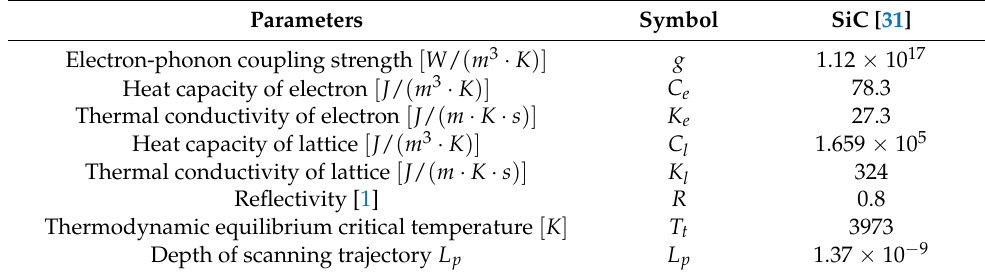
Table 2. Thermophysical parameters of